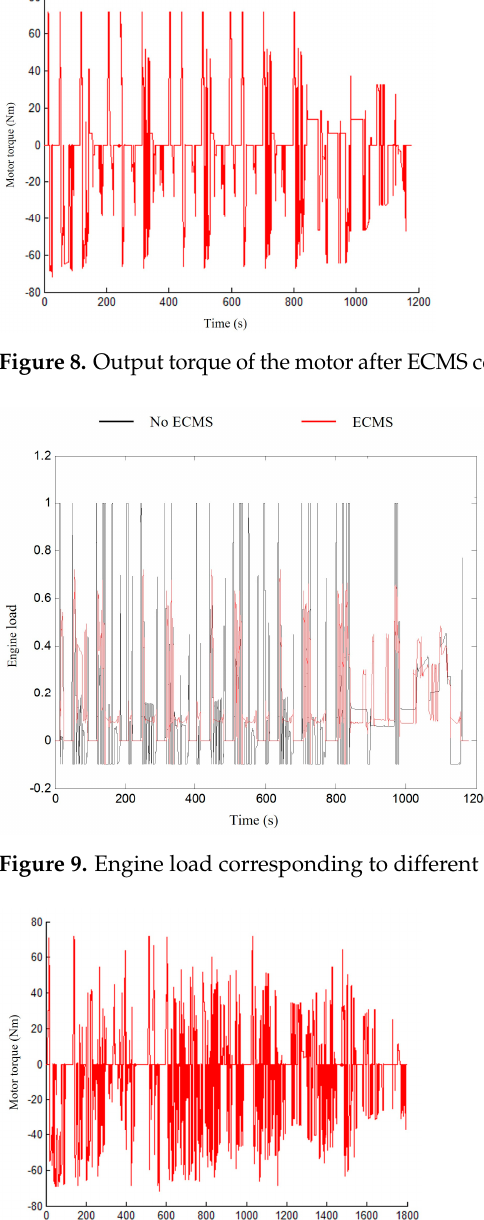
Figure 10. Motor output torque after ECMS control strategy participation under WLTP test conditions.